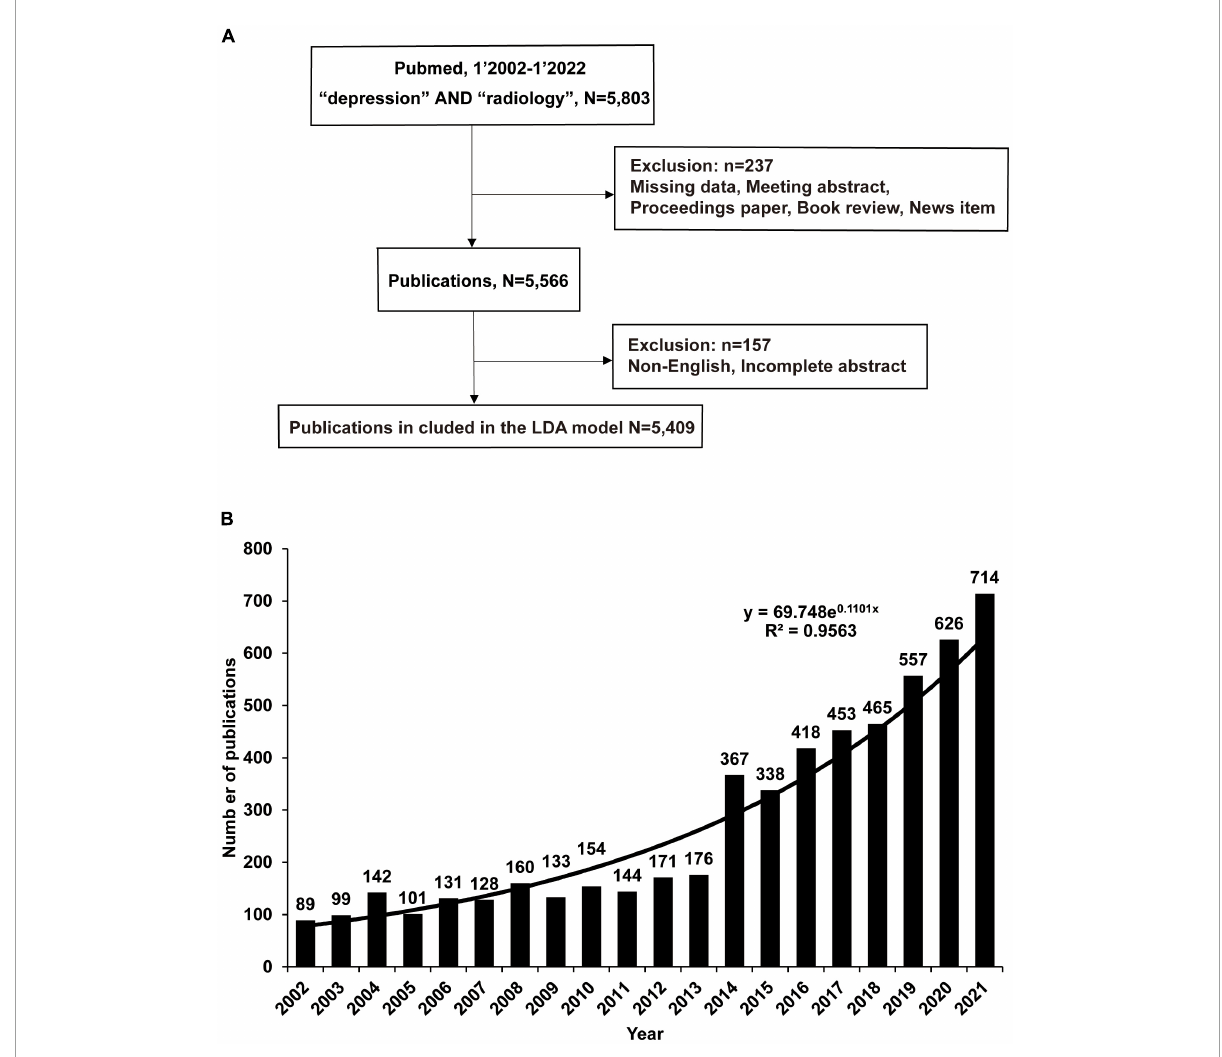
FIGURE1 The number of publications on radiology and depression has increased rapidly over the past 20 years. (A) Using the search terms depression and radiology in the PubMed database, download publications through the R pubquery package. Missing data or when the publication was